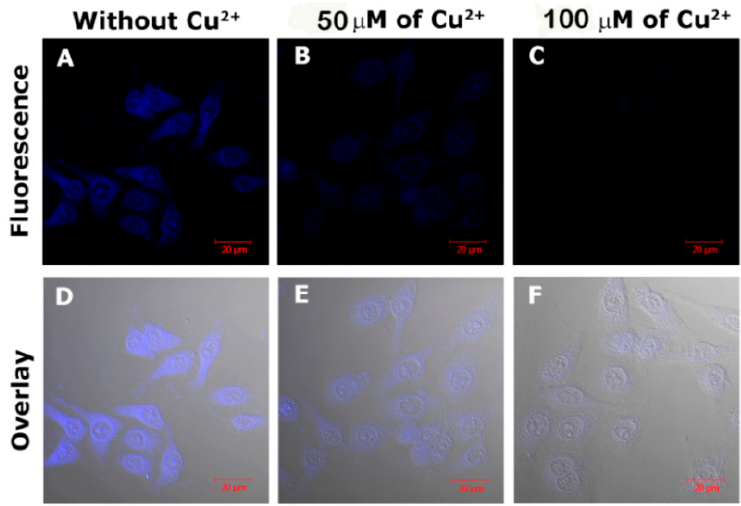
Figure 9. Confocal images of HeLa cells incubated with FCDs sensor (FCD, 50 µ g mL − 1 , A , D ) and treated with 50 µ M ( B , E ) and 100 µ M ( C , F ) of Cu 2+ . The overlay images confirm the signals are from in-cell FCDs, not interference.